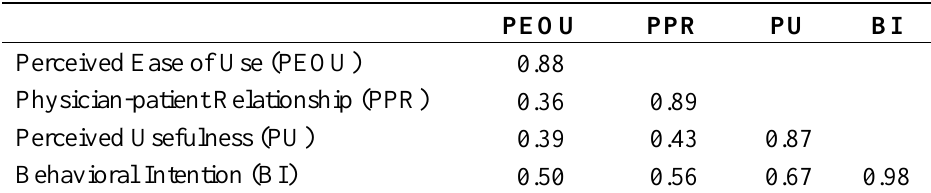
Table 2. Correlation matrix of constructs.